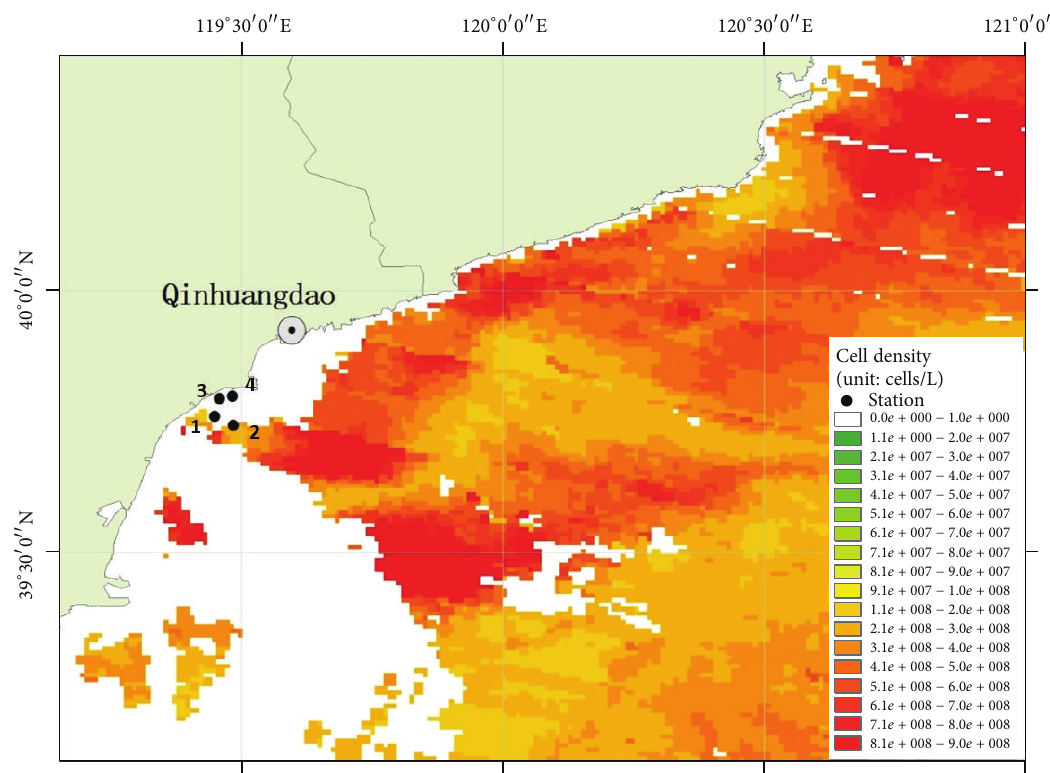
Figure 6: Cell density distribution of using multiband inversion